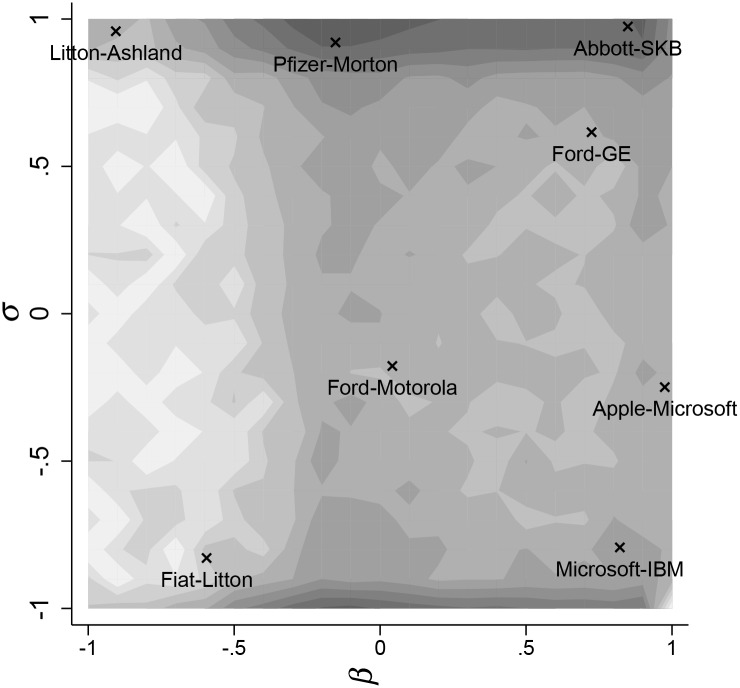
Number of dyads in the empirical β-σ space, by deciles.